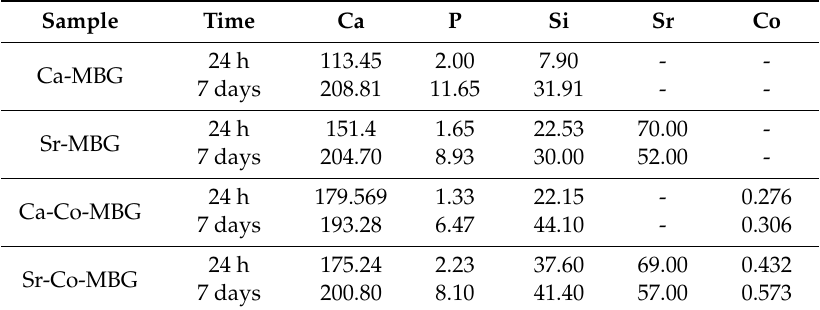
Table 7. Results of ICP measurements in SBF (ion leaching test).